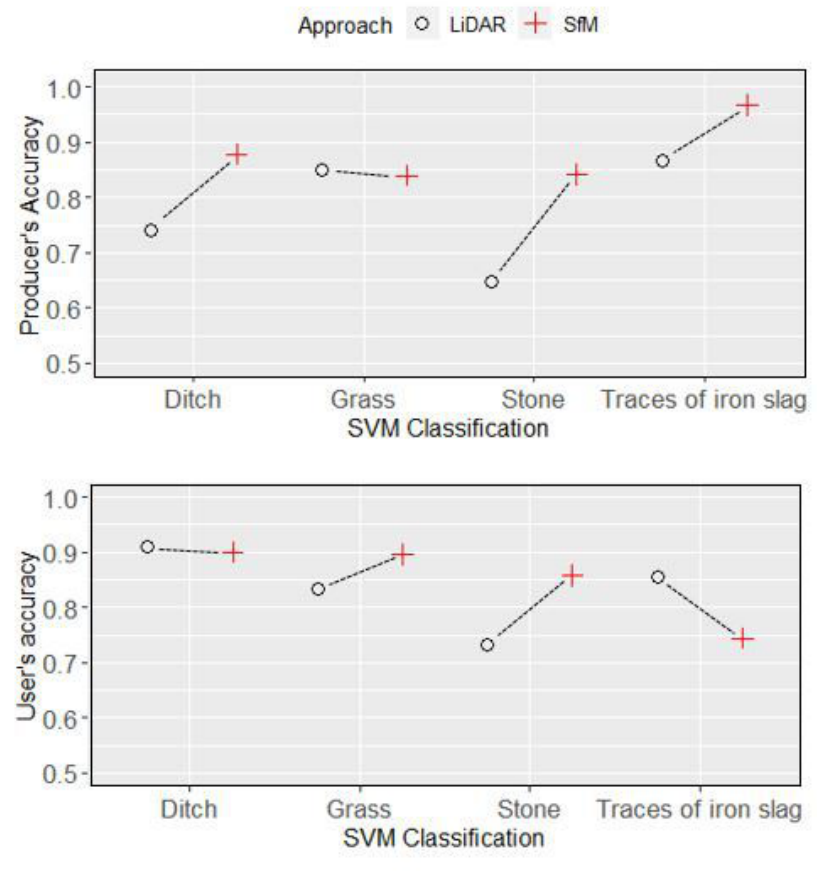
Figure 8. Accuracy assessment analysis to measure the renderings of the applied classification